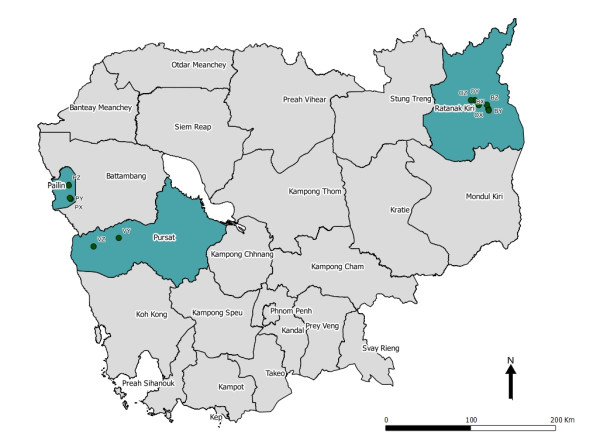
Map of study sites.